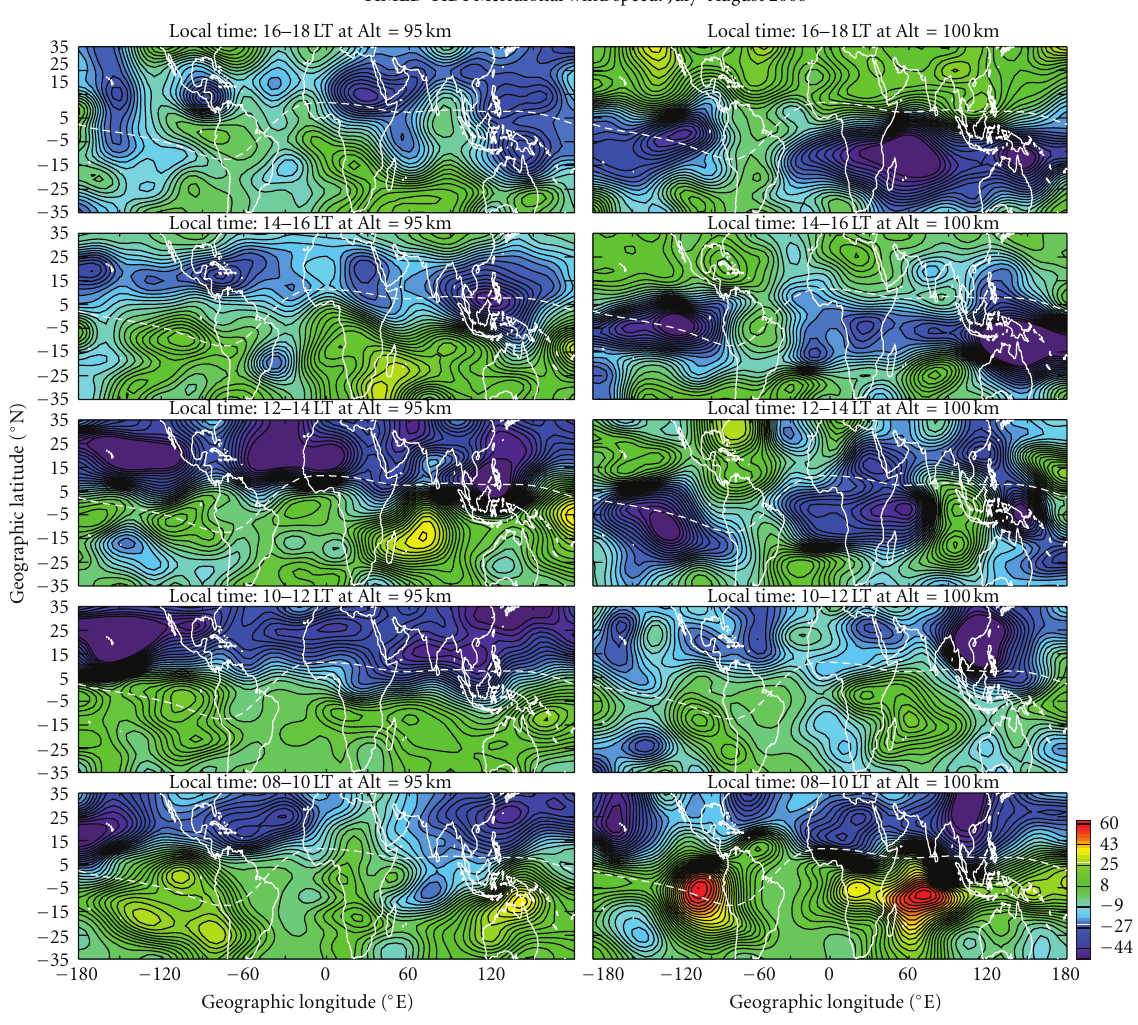
Figure 3: As for Figure 2 but it is for meridional wind